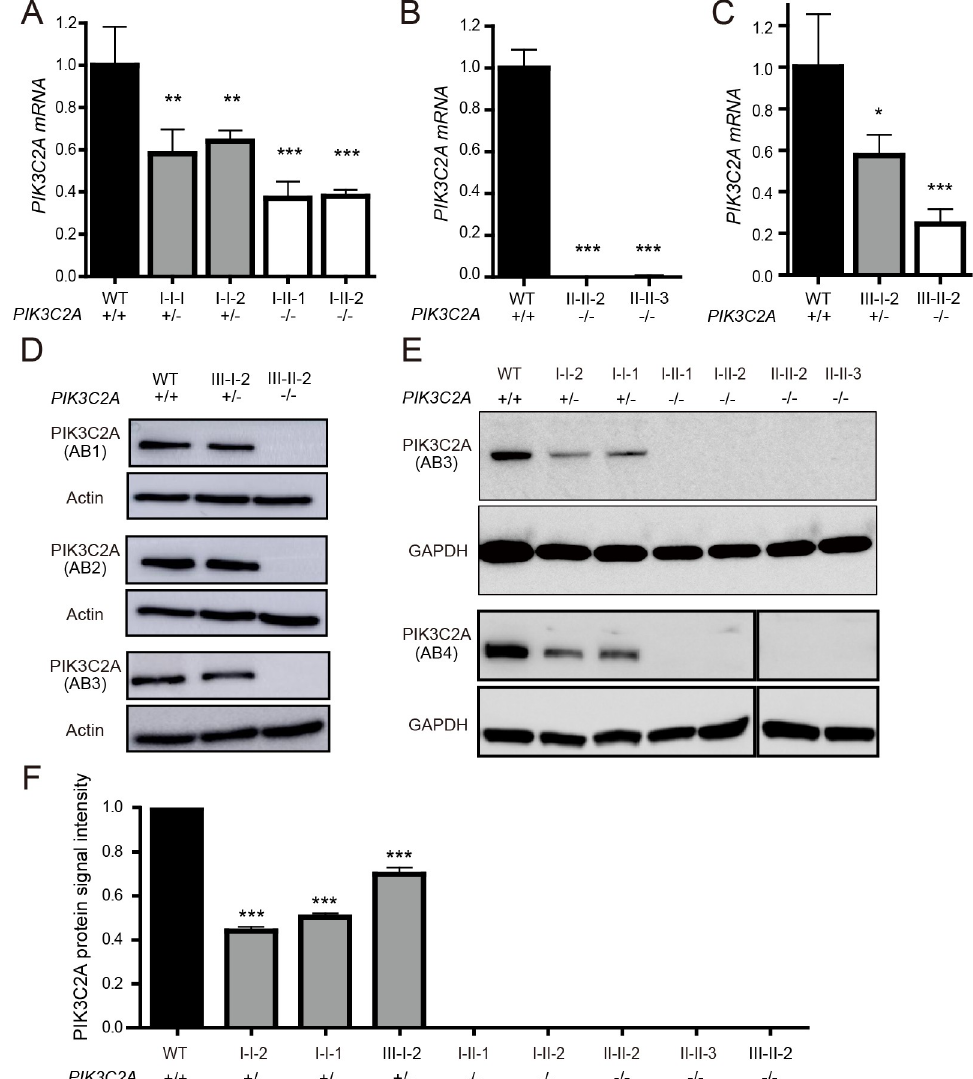
Fig 2. Protein and mRNA levels of PIK3C2A in patient-derived cells. PIK3C2A mRNA levels were detected by qRT-PCR in patient derived fibroblasts from (A) Family I, (B) Family II, and (C) Family III. The WT sample in Fig 2A is based on n = 1 individual, the WT sample in Fig 2B is based on n = 3 individuals, and the WT sample in Fig 2C is based on n = 1 individual, totaling n = 5 different WT samples. qRT-PCR data is represented as mean ± SEM (n = 3–4 technical replicates per sample). (D, E) Whole cell lysates from fibroblasts of healthy controls (WT), heterozygous parents, and affected individuals from (D) Family III and (E) Families I and II were analyzed by Western blotting for PIK3C2A and the loading controls Actin or GAPDH. Immunogen of anti-PIK3C2A antibodies (AB1-AB4) are detailed in S5 Table. (F) Densitometry of Western blot results was performed using ImageJ. Individual samples are shown with the data combined from the four different PIK3C2A antibodies used, with the exception of the WT samples which includes fibroblasts from two individuals. � indicates p < 0.05. �� indicates p < 0.01. ��� indicates p < 0.0001.